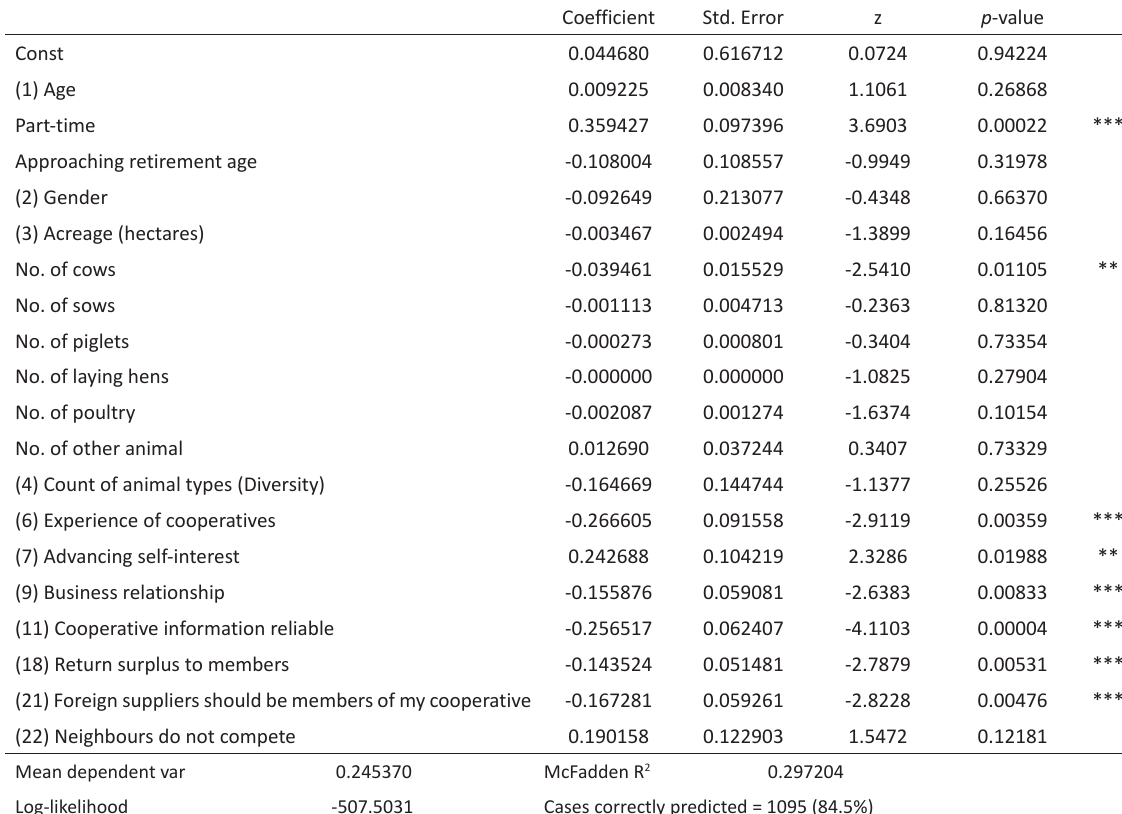
Table 2: Coefficients obtained with the binary probit model (model 3), robust standard errors. Dependent variable = ‘Respondent did not report membership of any